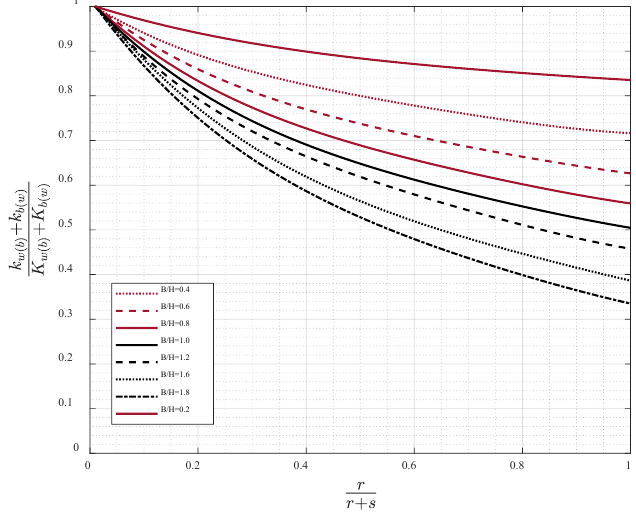
Figure 6. Control surface—control over stability contribution for elliptical sections [29].